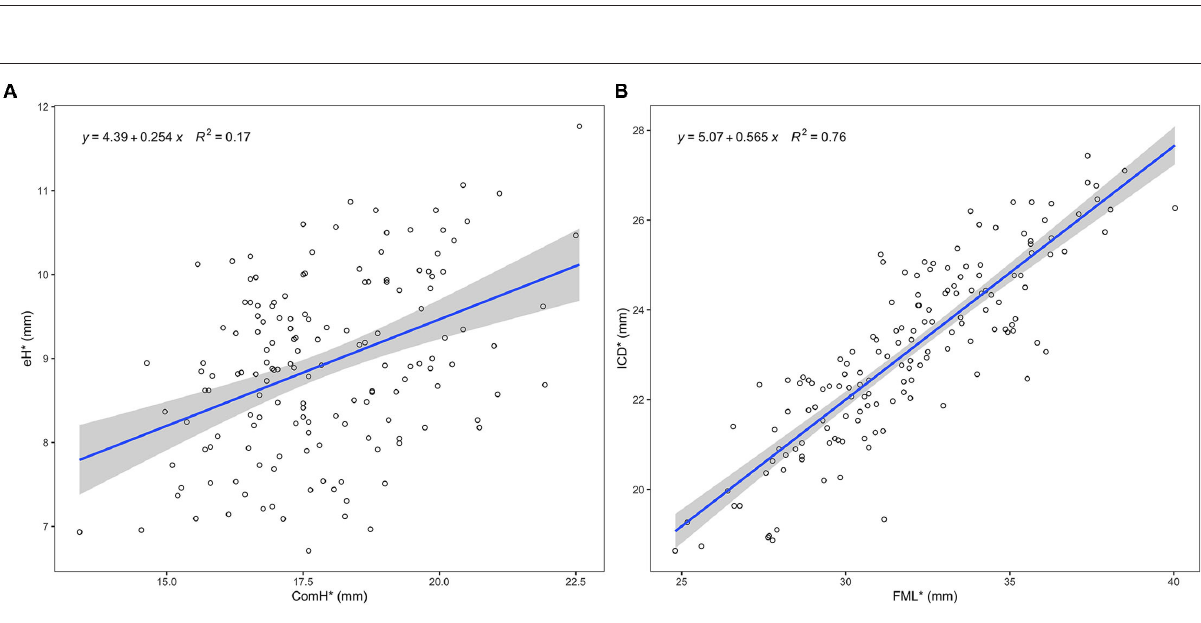
Frontiers in Cardiovascular Medicine |